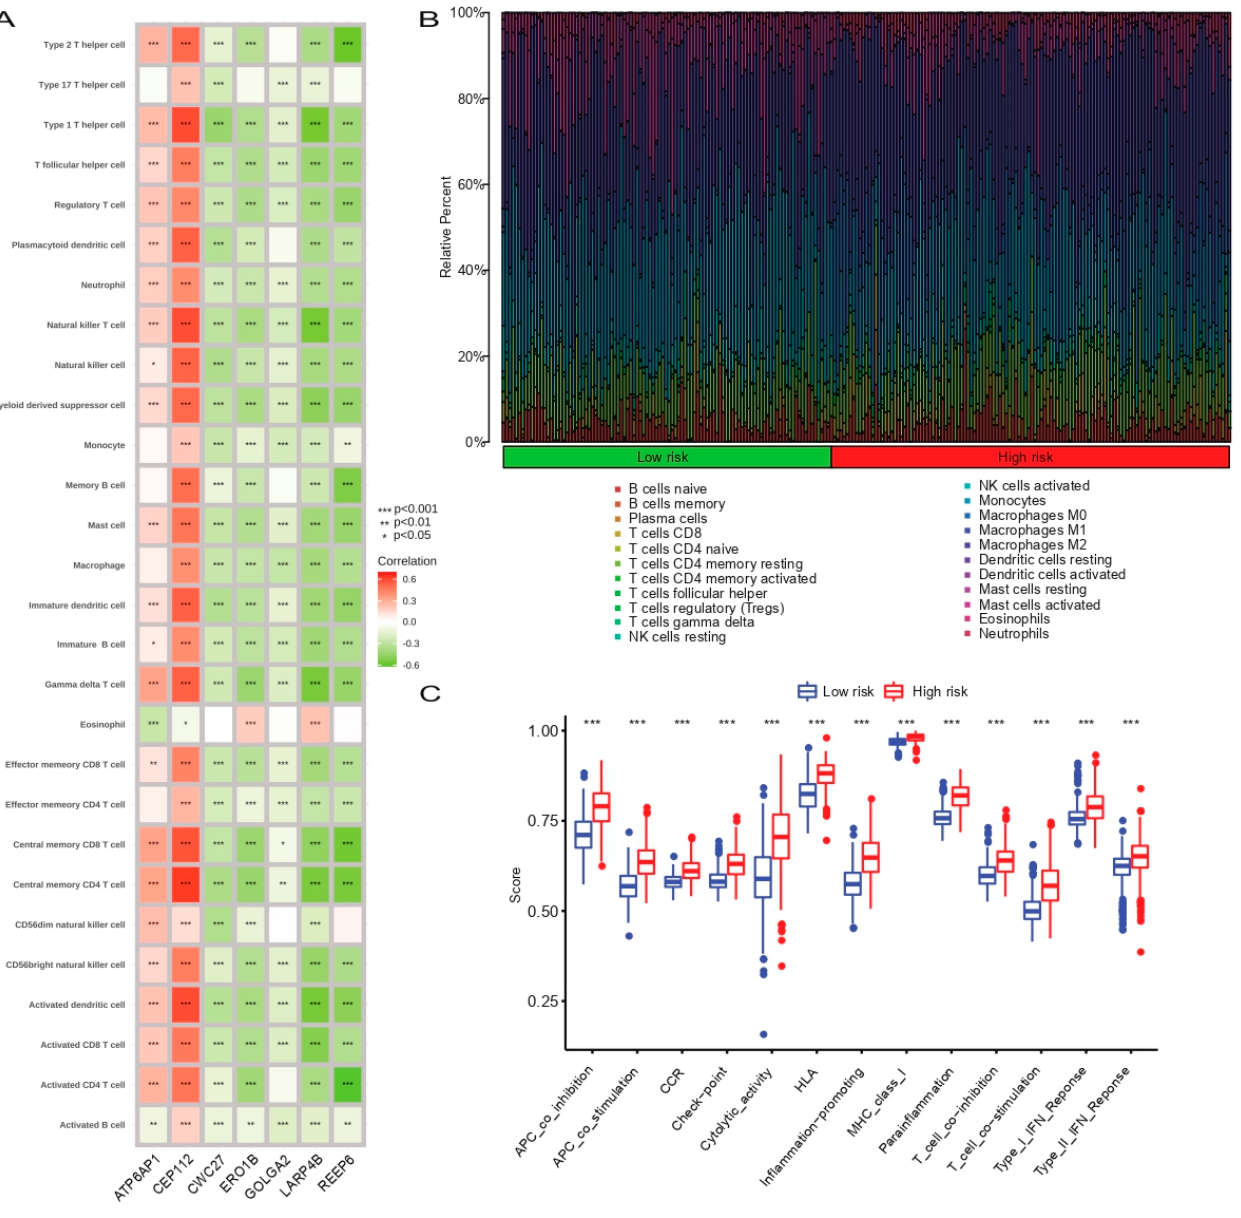
Figure 6. Correlation between the modeling genes and infiltrating immune cells based on ssGSEA. ( A ) Comparison of immune cell infiltration level ( B ) and immune score ( C ) between high- and low-isk groups. ssGSEA, single sample gene set enrichment analysis. *** p < 0.001, ** p < 0.01, * p < 0.05.